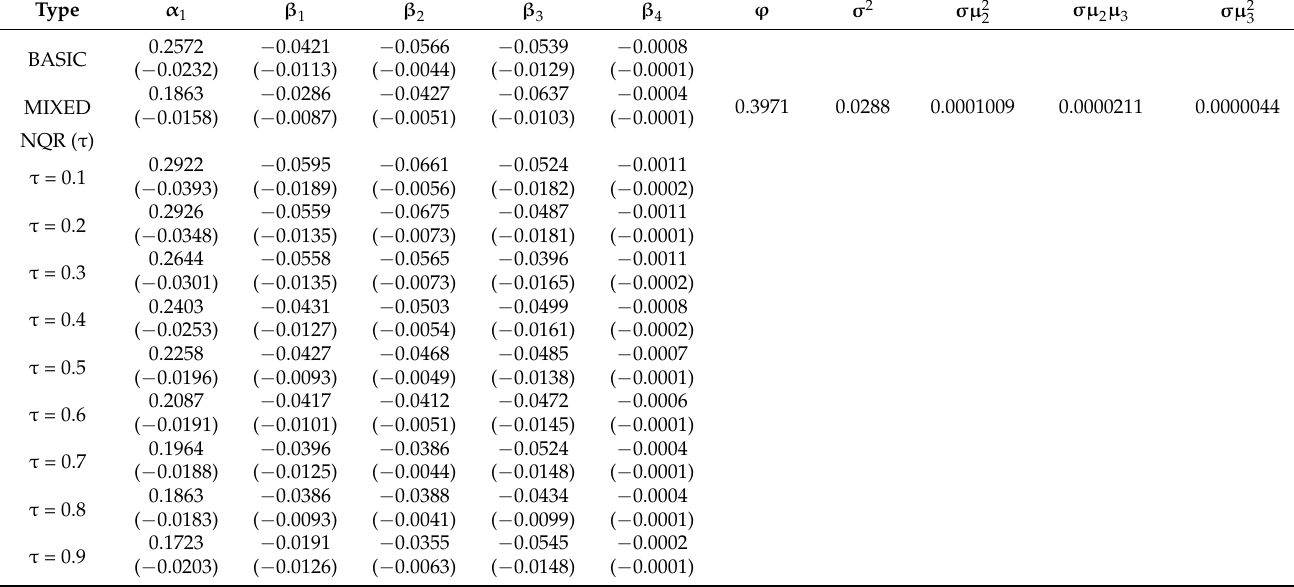
Table A5. Parameter estimates (standard error) of the basic, mixed, and NQR models at different quantiles ( τ ) for